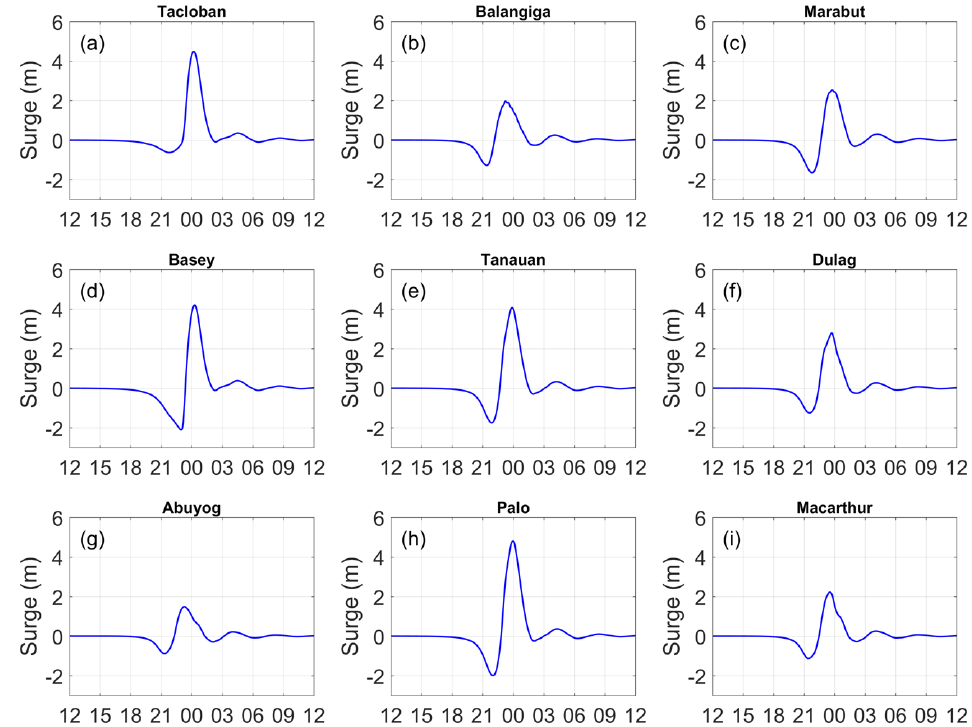
Figure 8. ( a – i ) Time series of the computed storm surges driven by HWM at the numerical gauges. The information of numerical gauges can be found in Figure 2b and Table 2. The x -axis indicates the time from 12:00 UTC 7 November 2013 to 12:00 UTC 8 November 2013.